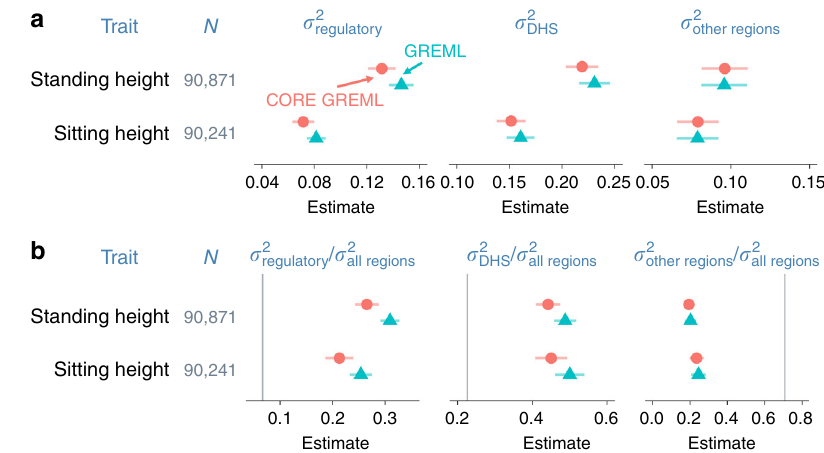
Fig. 5 Variance estimates from genome-transcriptome partitioning analyses. N = sample size; σ 2 the genome and by the imputed transcriptome, respectively. Model parameters were estimated using the traditional method, i.e., GREML, and the proposed method, i.e., CORE GREML. Error bars are 95% con fi dence intervals (based on s.e.m.). Residual variance estimates are omitted for simplicity. Source data are provided as a Source Data fi le.